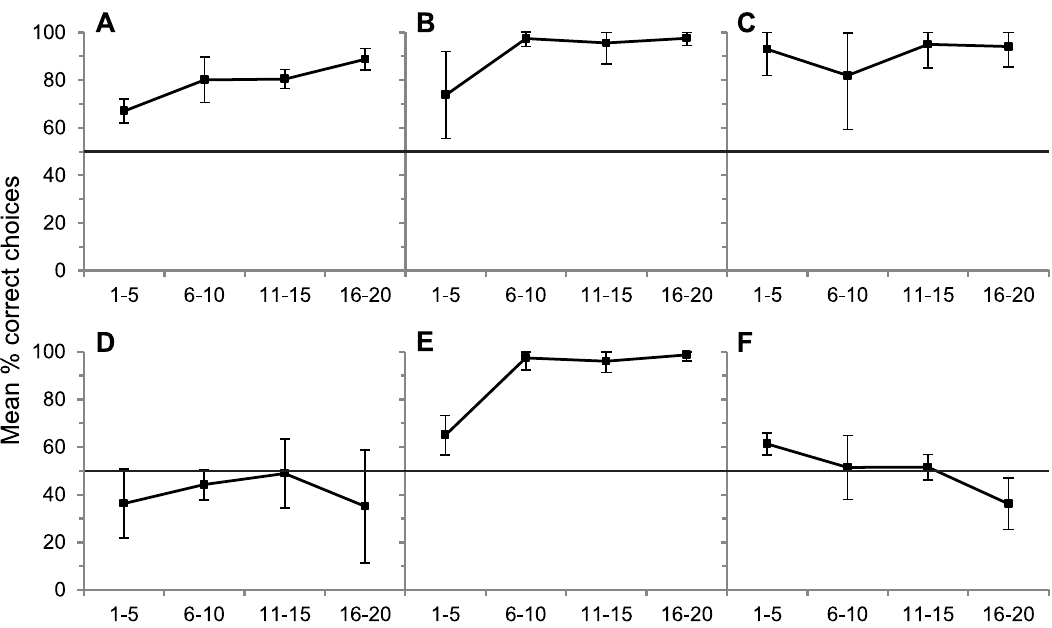
Figure 3. Changes in mean performance over the course of each experiment. Each panel gives the mean percent correct choices over trials 1–5, trials 6–10, 11–15 and 16–20, in each experiment, to indicate changes in performance over the course of 20 trials. (A: Sand v Water, B: Sinking v Floating, C: Solid v Hollow, D: Narrow v Wide, E: High v Low water level, F: U-tube.) Error bars are 6 2 SE.